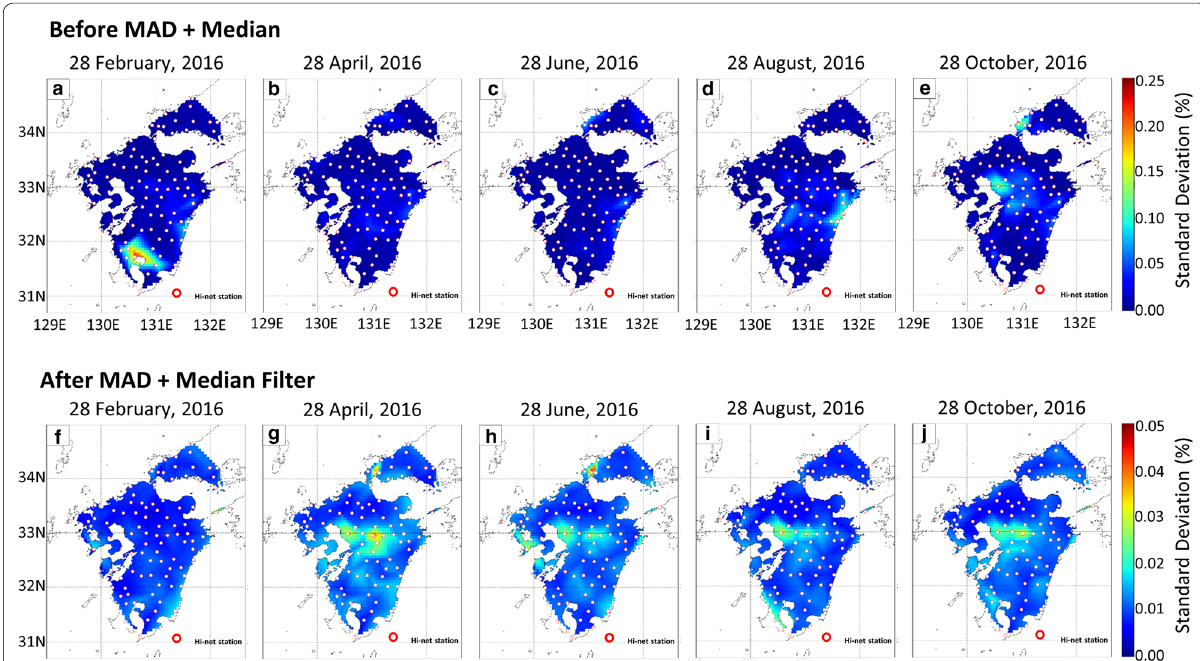
Fig. 9 Error maps determined by using the SRM. a – e Without MAD and a median filter and f – j with MAD and a median filter. Note that color scales for panels a – e and f – j are different. By considering outlier data using our approach, the errors of velocity variations can be significantly